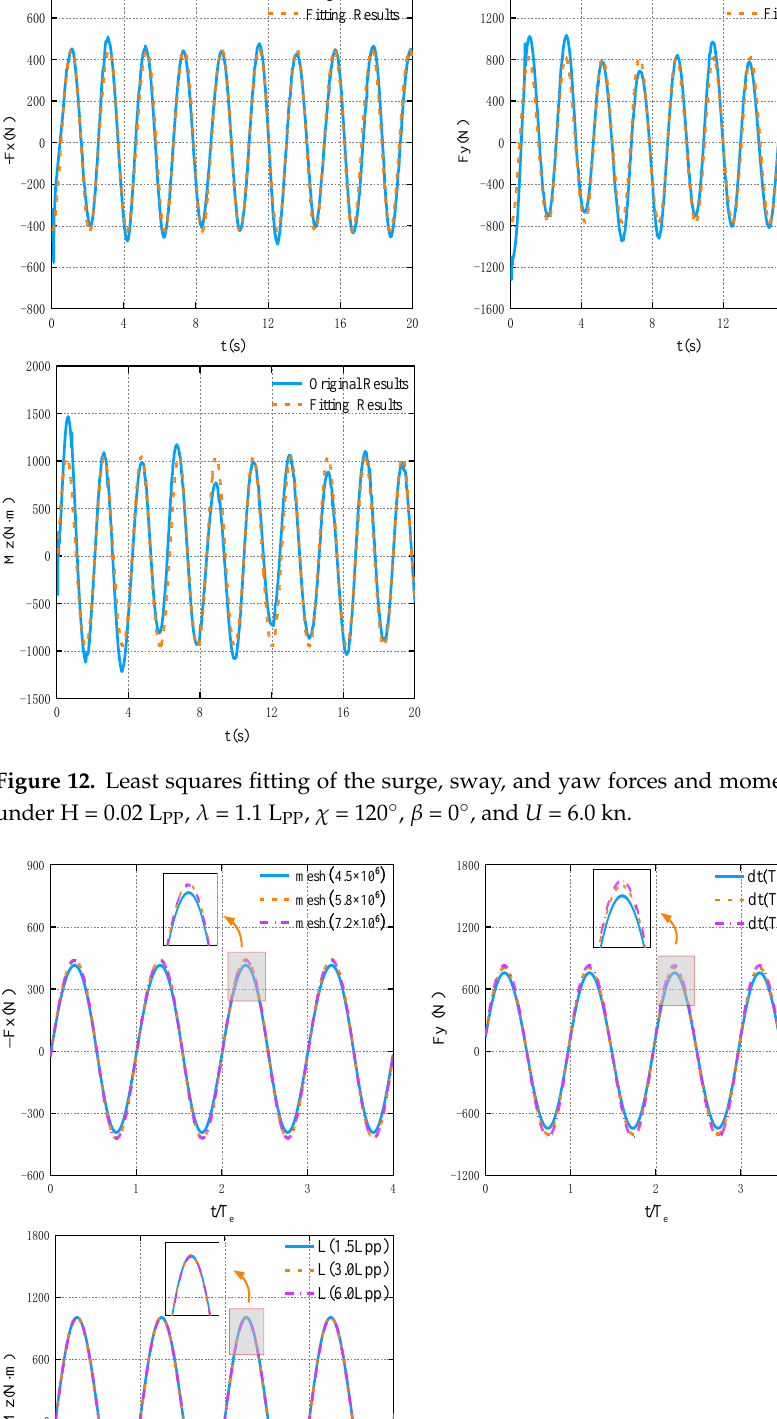
Figure 11. Grid diagram of the damping zone of the computing domain.